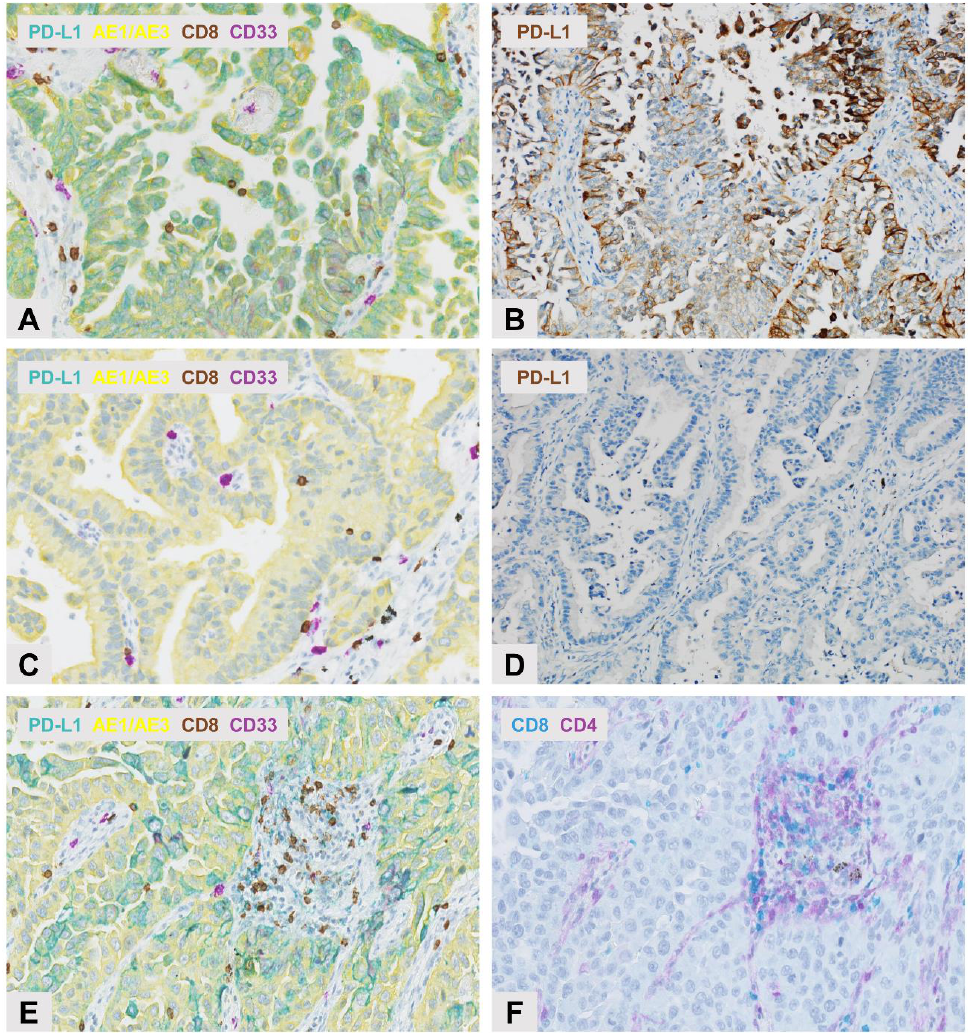
Figure 1. Multiplex immunohistochemistry (IHC) detection of programmed death ligand 1 PD-L1 expression and selected immune cell subpopulations in sequential whole tissue sections of lung adenocarcinoma (LADC). Upper panel: strong PD-L1 expression observed in the same LADC case following ( A ) PD-L1 (Teal) and AE1/AE3 (Yellow) chromogenic labeling showing the co-expression of PD-L1 and pan-Keratin AE1/AE3 in neoplastic cells, and ( B ) by immunoperoxidase (brown) with no clear distinction between PD-L1 labeling in tumor cells (TCs) or stromal cells. Original magnification, × 200. Middle panel: absence of PD-L1 expression observed in the same LADC case following ( C ) PD-L1 (Teal) and AE1/AE3 (Yellow) chromogenic labeling, and ( D ) with immunoperoxidase (brown). Original magnification, × 200. Lower panel: IHC detection of immune cell subpopulations in sequential sections of LADC following ( E ) Multiplex chromogenic detection by DAB staining (brown) of CD8 + lymphocytes and purple staining of CD33 + MDSCs, and ( F ) Teal immunolabeling of CD8 + lymphocytes and purple staining of CD4 + lymphocytes.